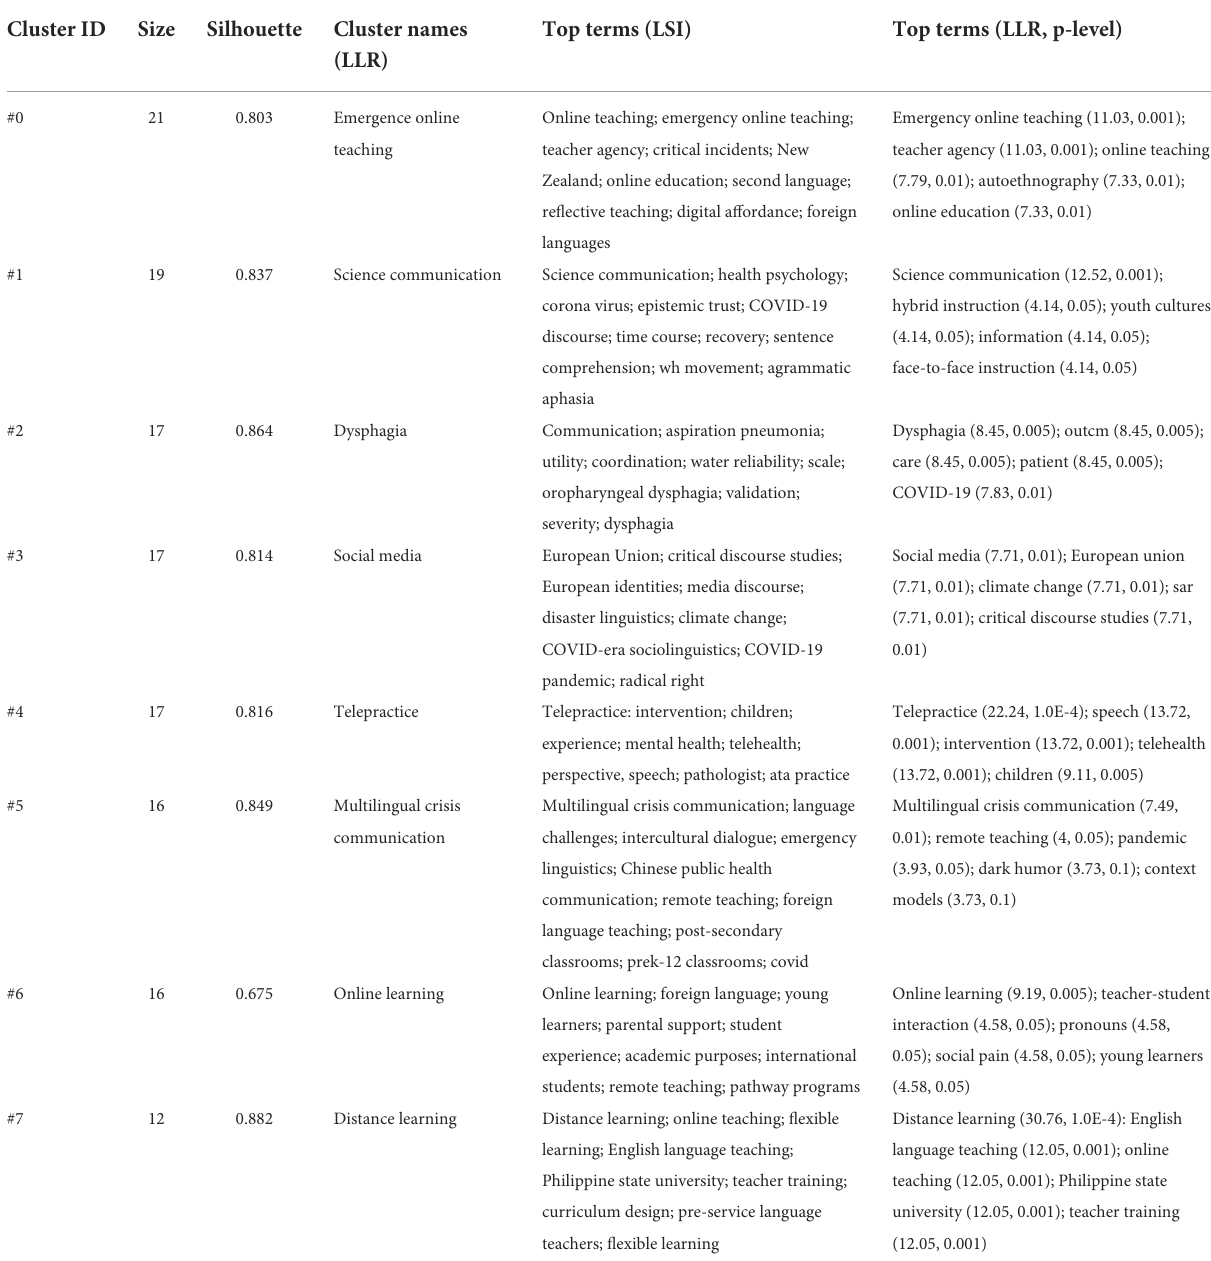
TABLE 6 Important clusters of keywords in linguistic research on